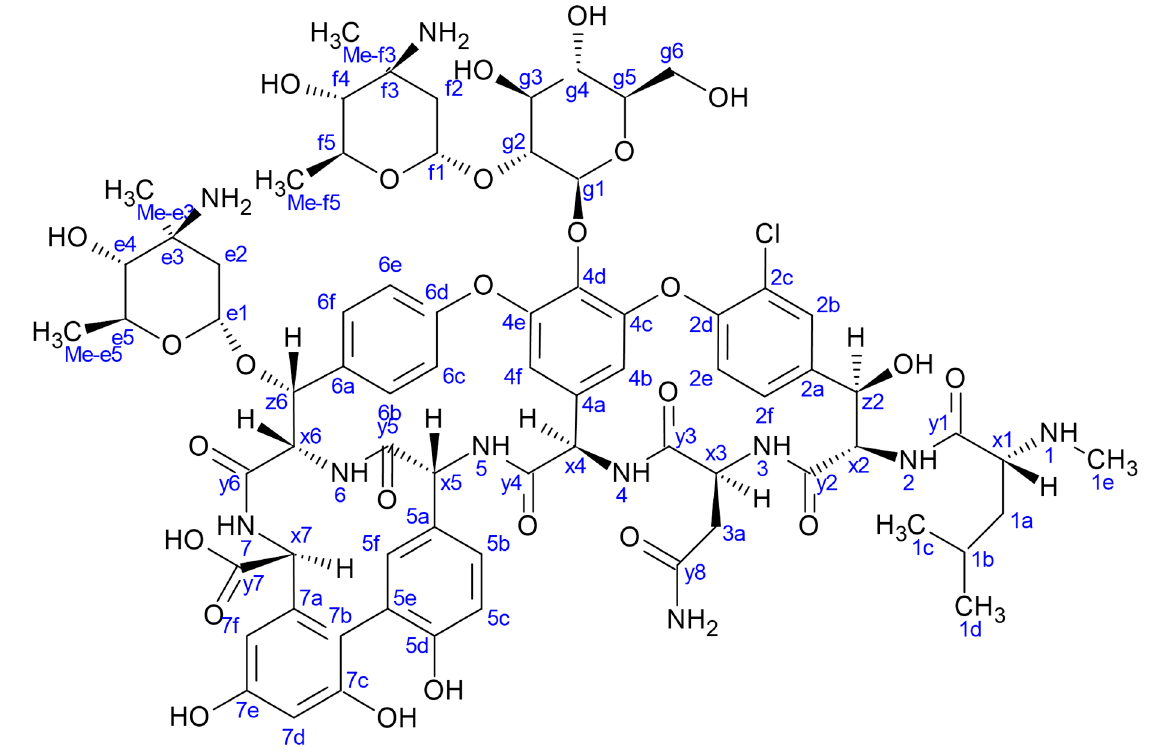
Figure 1. The structure of eremomycin. Labels e and f indicate eremosamine; g indicates glucopyranose sugar units. Numbering accord to amino acid sequential order, x stand for α -CHs, y stand for carbonyl carbon atoms.